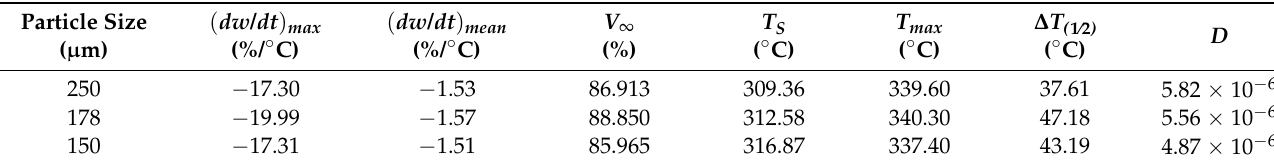
Figure 5. ( a ) Cellulose TG curve; ( b ) Cellulose DTG curve. Table 4. Pyrolytic properties of